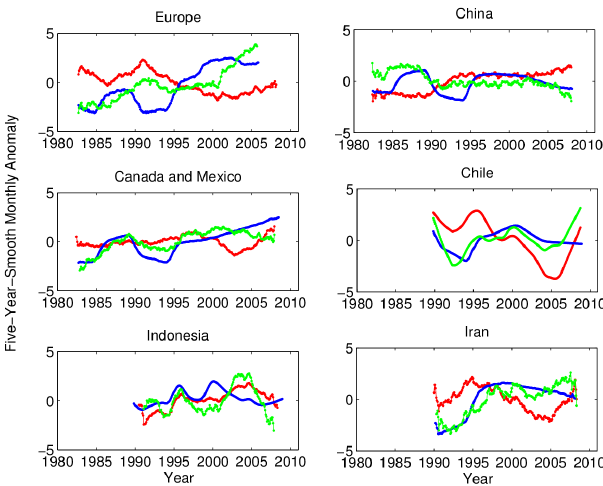
Fig. 9. Five-year smoothed monthly R s anomalies derived from SunDu as averaged over geographic regions (green line). For comparison, the Five-year smoothed clear-sky fraction (1 − F c , red Line) derived from meteorological total cloud fraction measurement ( F c ) and negative of column aerosol optical depth (-AOD, blue Line) are also shown. Clear sky fraction and negative AOD are shown here because they are positively correlated with R s , i.e., both terms imply changes of R s of the same sign. The 1165 stations are divided into six regions based on the data availability and their trends: (a) Europe (35 ° N-65 ° N, 10 ° W-40 ° E), (b) China (20 ° N-55 ° N, 55 ° E-150 ° E), (c) North America (primarily Canada and Mexico, 15 ° N-65 ° N, 160 ° W-60 ° W),, (d) Chile (60 ° S-15 ° N, 90 ° W-35 ° W), (e) Indonesia (20 ° S-20 ° N, 65 ° E-130 ° E), and (f) Iran (20 ° N-50 ° N, 30 ° E-55 ° E).